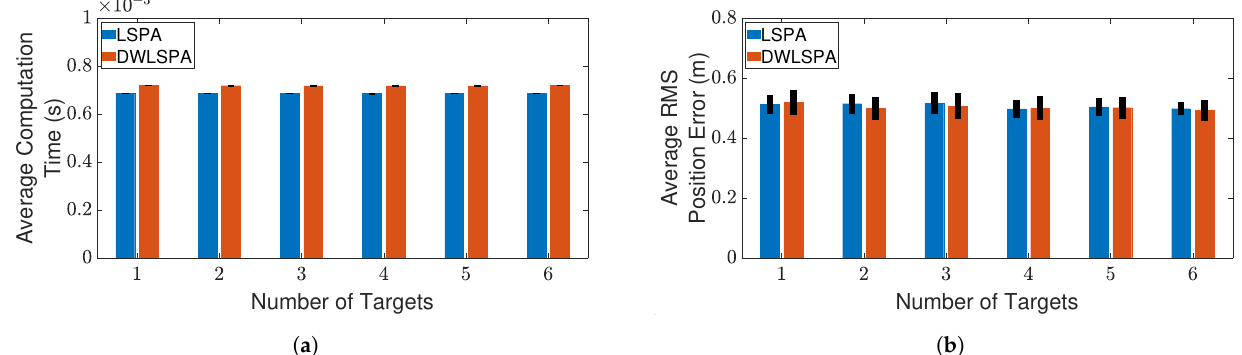
Figure 11. Tracking multiple crossing targets using LSPA and DWLSPA with clutter density λ = 5 × 10 − 4 /m 2 . ( a ) Av- erage computation time for obtaining association probabilities; ( b ) average RMS position error. Error bars indicate 95% confidence intervals.